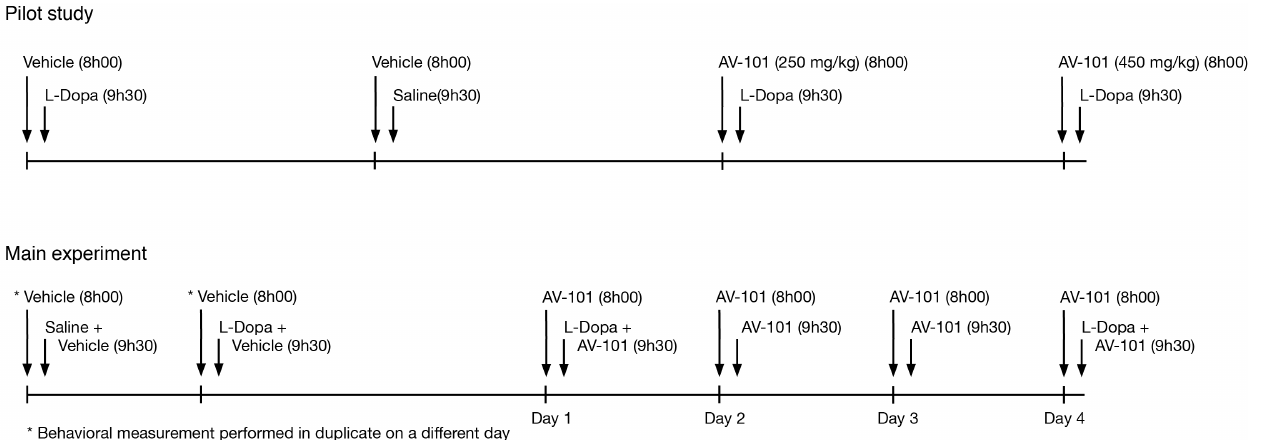
Figure 1. Schematic timeline of AV-101 and L-Dopa administration in monkeys. ( A ) In the pilot study, AV-101 (250 and 450 mg/kg) was administered to 3 monkeys p.o. s.i.d. by nasogastric gavage 1.5 h before L-Dopa. ( B ) In the main experiment, AV-101 (250 mg/kg) was administered to monkeys p.o. b.i.d. for 4 consecutive days in combination with L-Dopa on days 1 and 4, and a